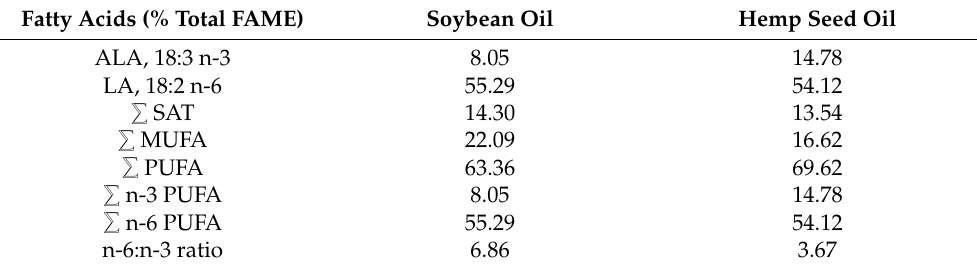
Table 2. Centesimal essential fatty acids composition of hemp seed oil compared to soybean oil.